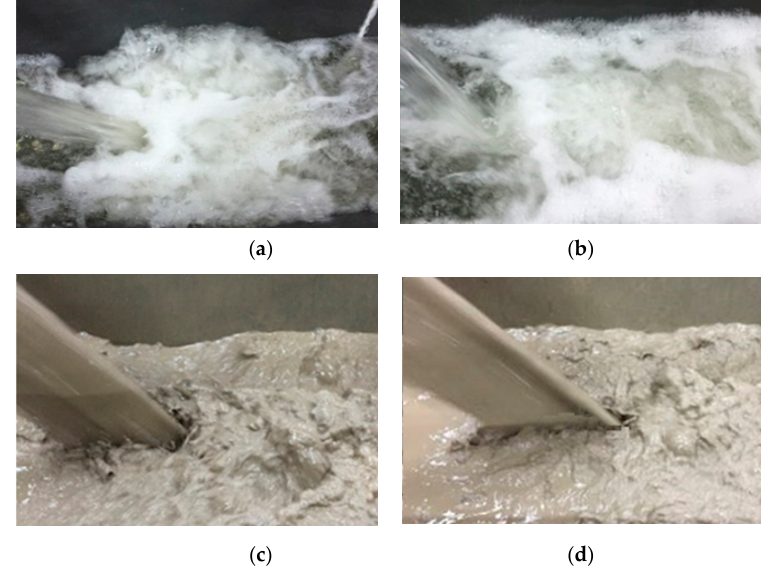
Figure 8. Flow regime of impact region in the plunge pool with upstream water head of 2.20 m and downstream water head of 0.15 m; ( a ) shape 1 of fresh water; ( b ) shape 3 of fresh water; ( c ) shape 1 of sediment-laden flow with a concentration of 150 kg/m 3 ; ( d ) shape 3 of sediment-laden flow with a concentration of 150 kg/m 3 .